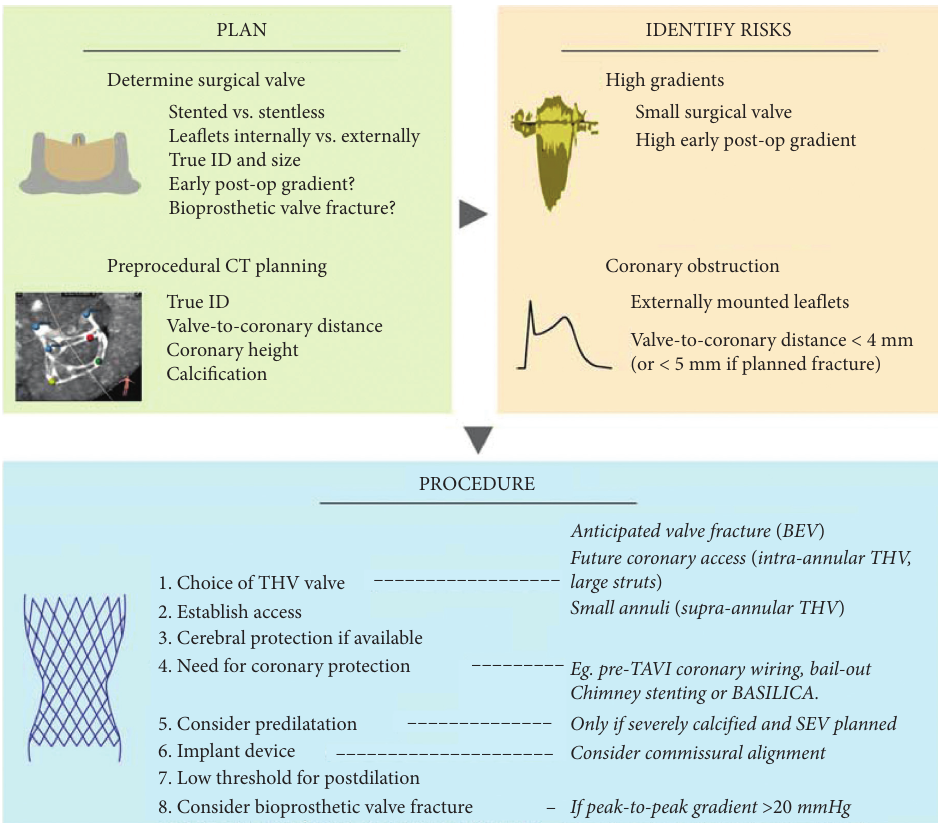
Figure 1: Practical approach to ViV-TAVI, with preprocedural planning to identify and address coronary occlusion or high residual gradients after TAVI. BEV: balloon-expandable valve; SEV: self-expandable valve; THV: transcatheter heart valve; TAVI: transcatheter aortic valve implantation; ID: internal diameter; BASILICA: bioprosthetic aortic scallop intentional laceration to prevent iatrogenic coronary artery